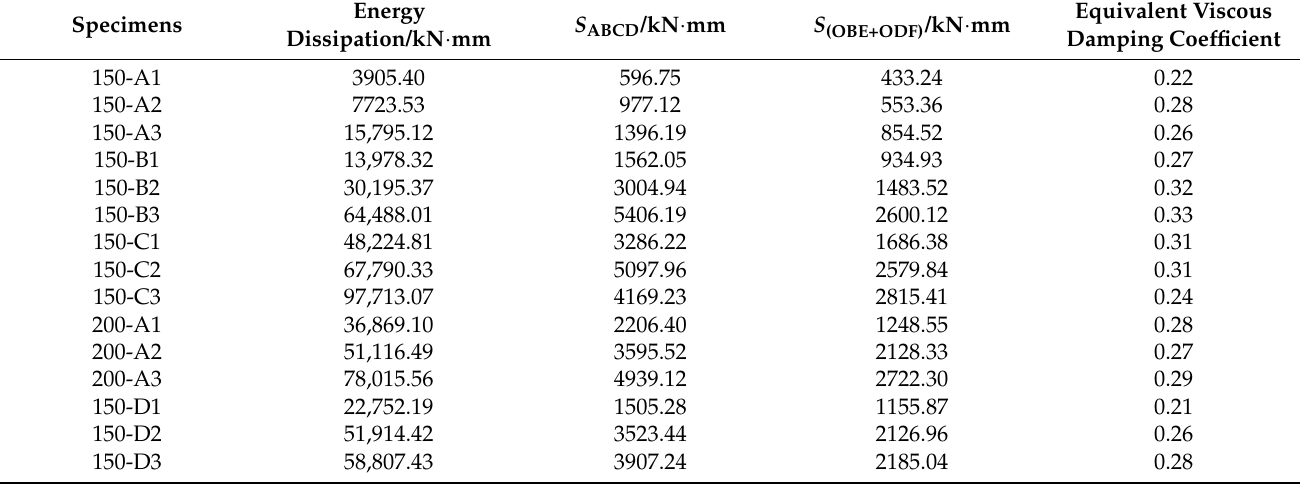
Table 4. Hysteresis loop area of welded seamless steel tube